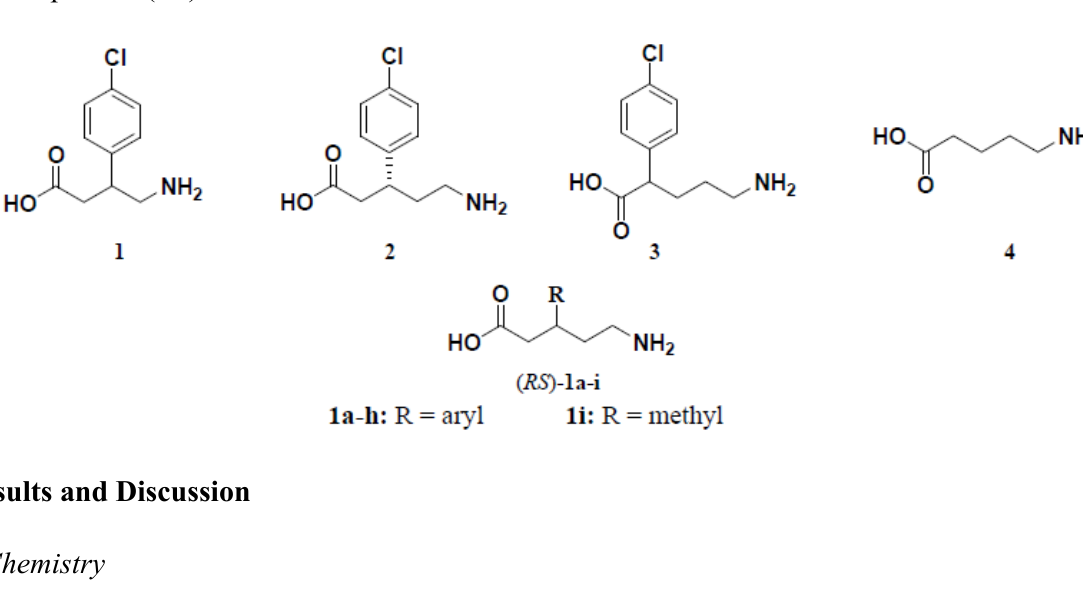
Figure 1. Chemical structures of baclofen ( 1 ), ( R )-homobaclofen ( 2 ), ( RS )-5-amino-2-(4- chloro- phenyl)pentanoic acid ( 3 ), 5-aminopentanoic acid (DAVA, 4 ) and the target compounds ( RS )- 1a – i